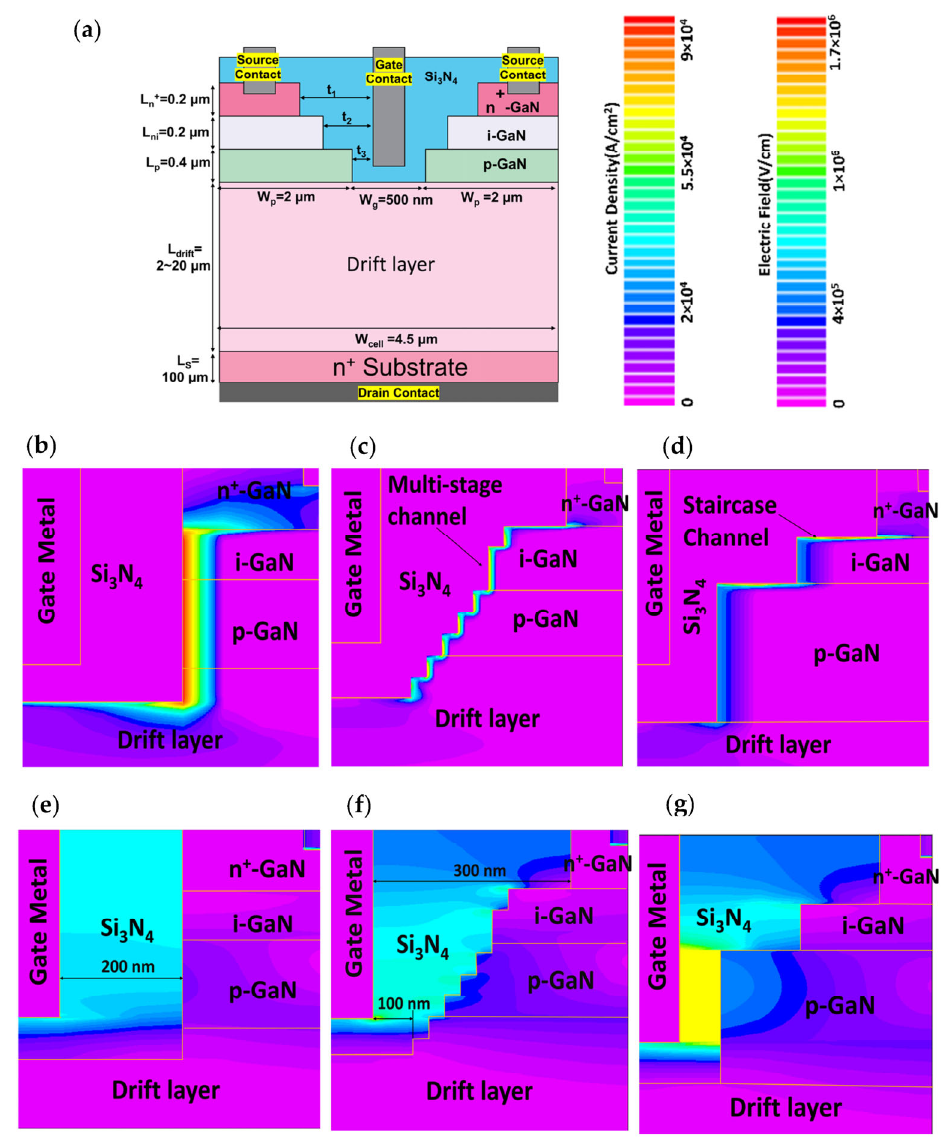
Figure 1. ( a ) Device structure of the proposed staircase channel transistor. Comparison of current density distributions in traditional straight channel ( b ), multi-stage staircase channel ( c ), and staircase channel ( d ) transistors. ( e – g ) Comparison of Electric field profiles of the traditional straight channel, multi-stage staircase channel, and staircase channel transistors respectively.